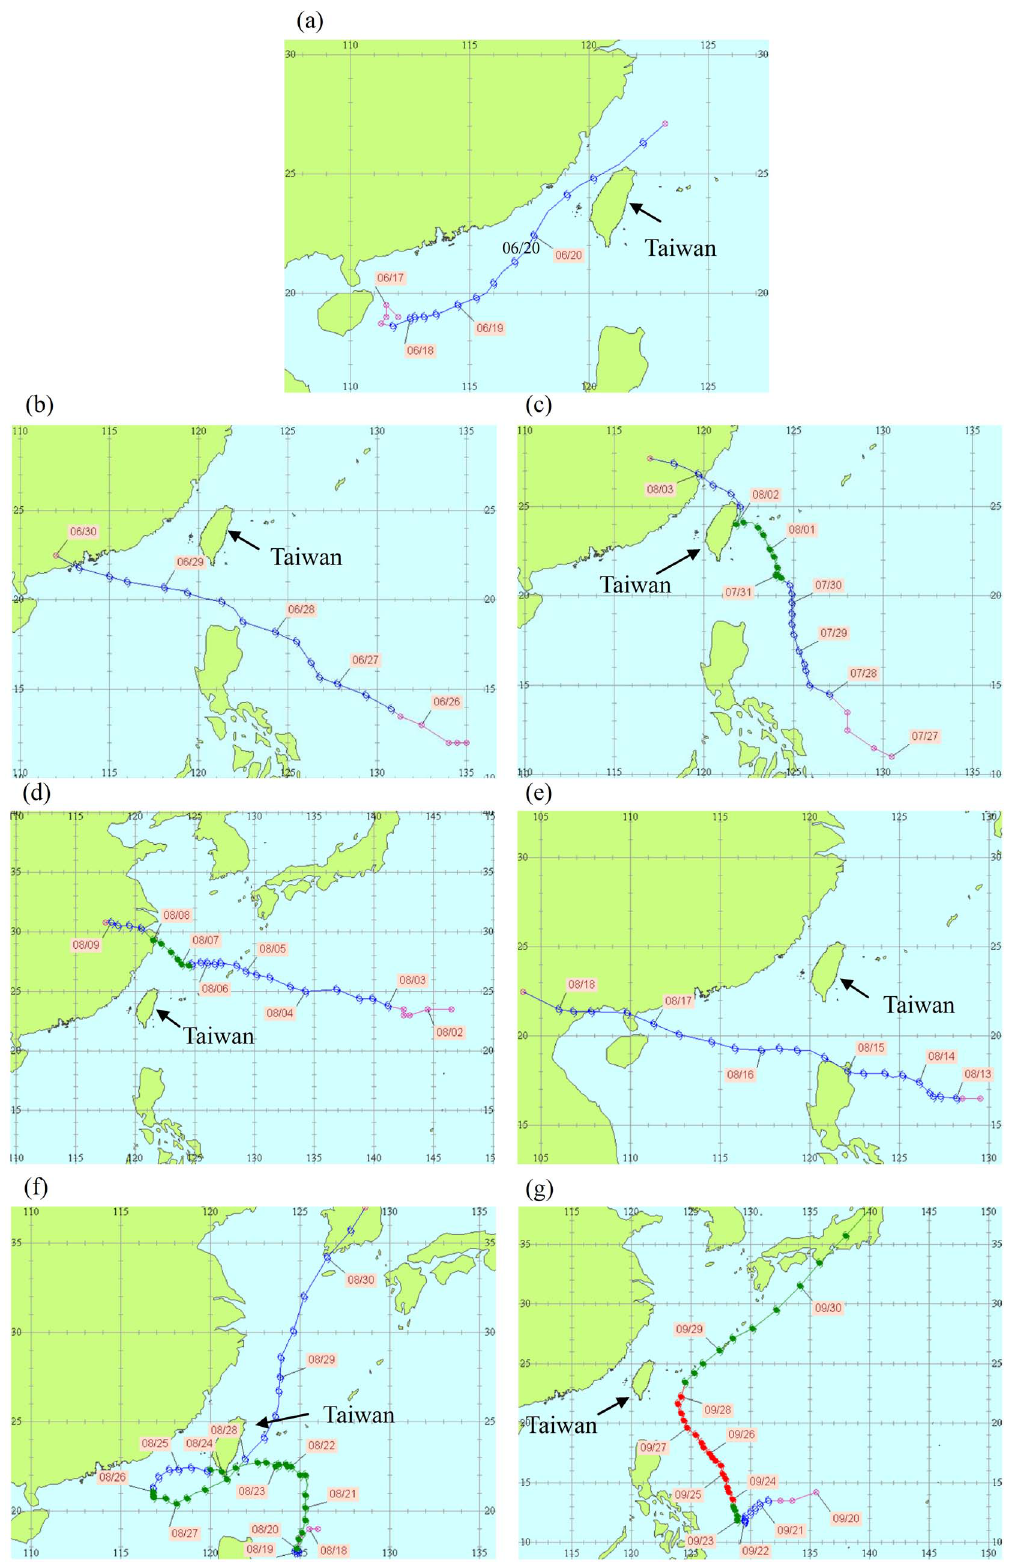
Figure 3. The path of (a) Talim, (b) Doksuri, (c) Saola, (d) Haikui, (e) Kai-Tak, (f) Tembin and (g) Jelawat Typhoon from Taiwan Central Weather Bureau.